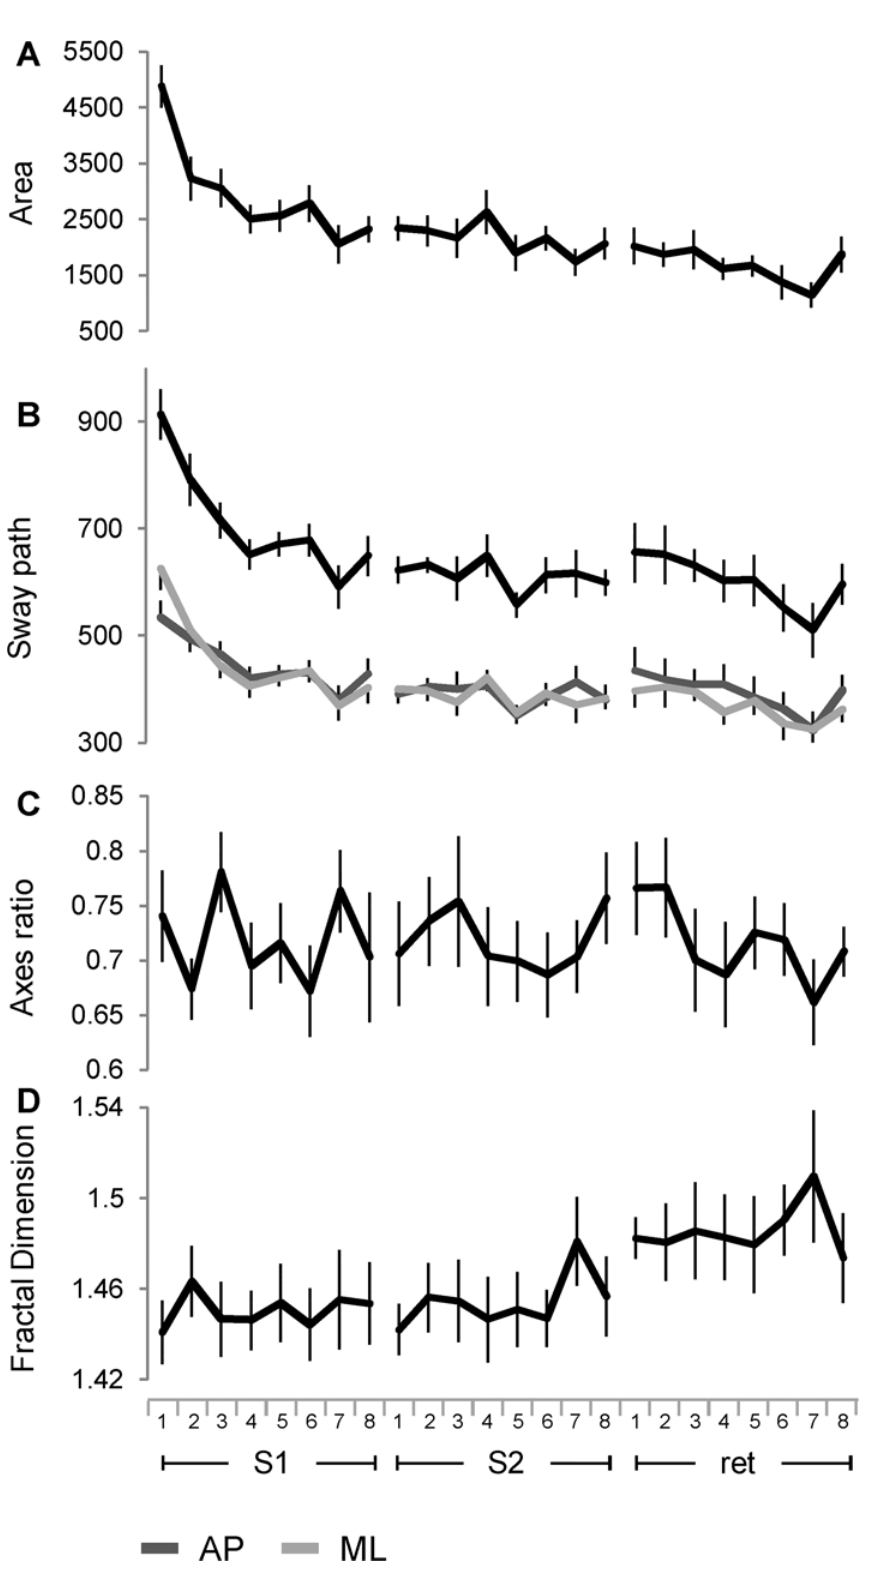
Fig 4. Changes in horizontal displacement of the board across the time course of learning. Area (A), sway path (B), 95% confidence ellipse axes ratio (C) and fractal dimension (D) computed from the trajectory of the unit normal vector. Symbols, units and abbreviations as in Figs 2 and